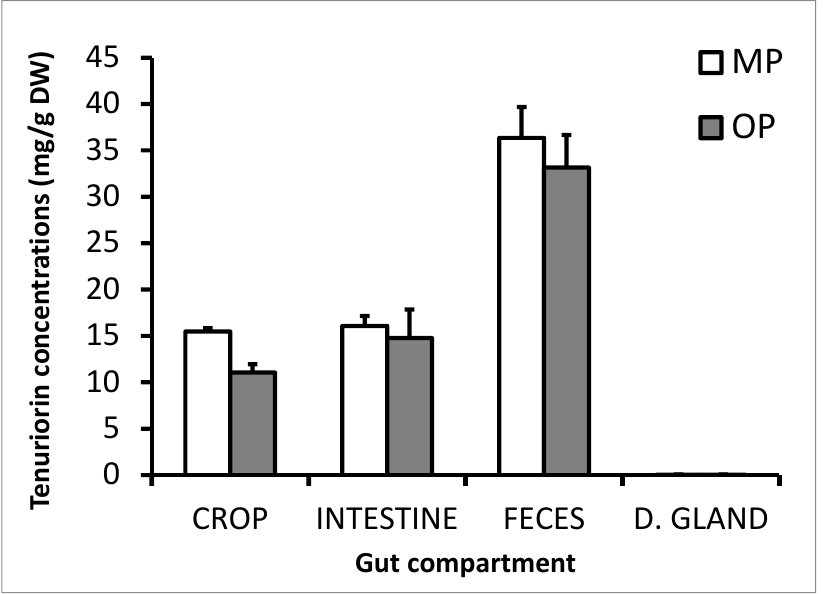
Figure 6. Levels of tenuiorin (means ± standard deviation) found in the snail gut compartments after the consumption of P. crocata , according to the snail phenotype (MP = Mineral and OP = Organic).